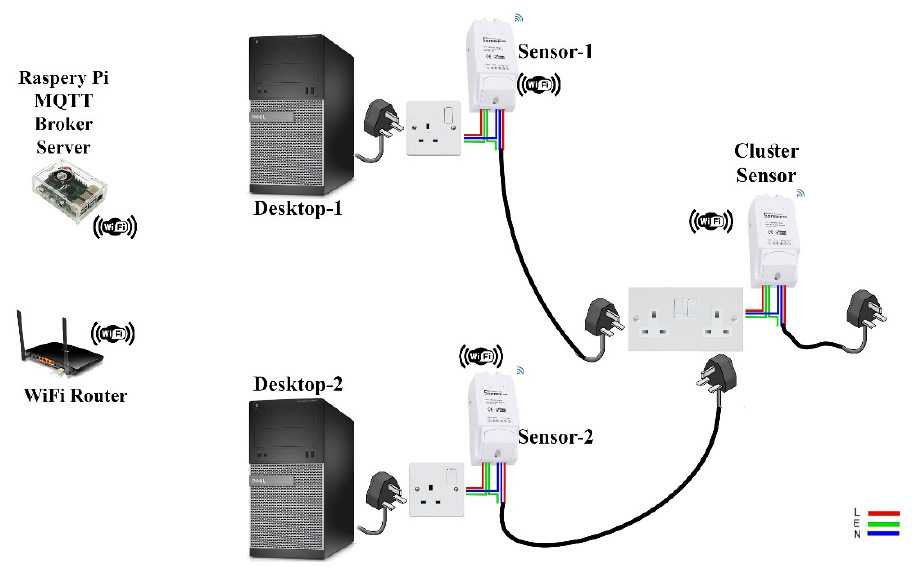
Figure 2. Experiment device connectivity.